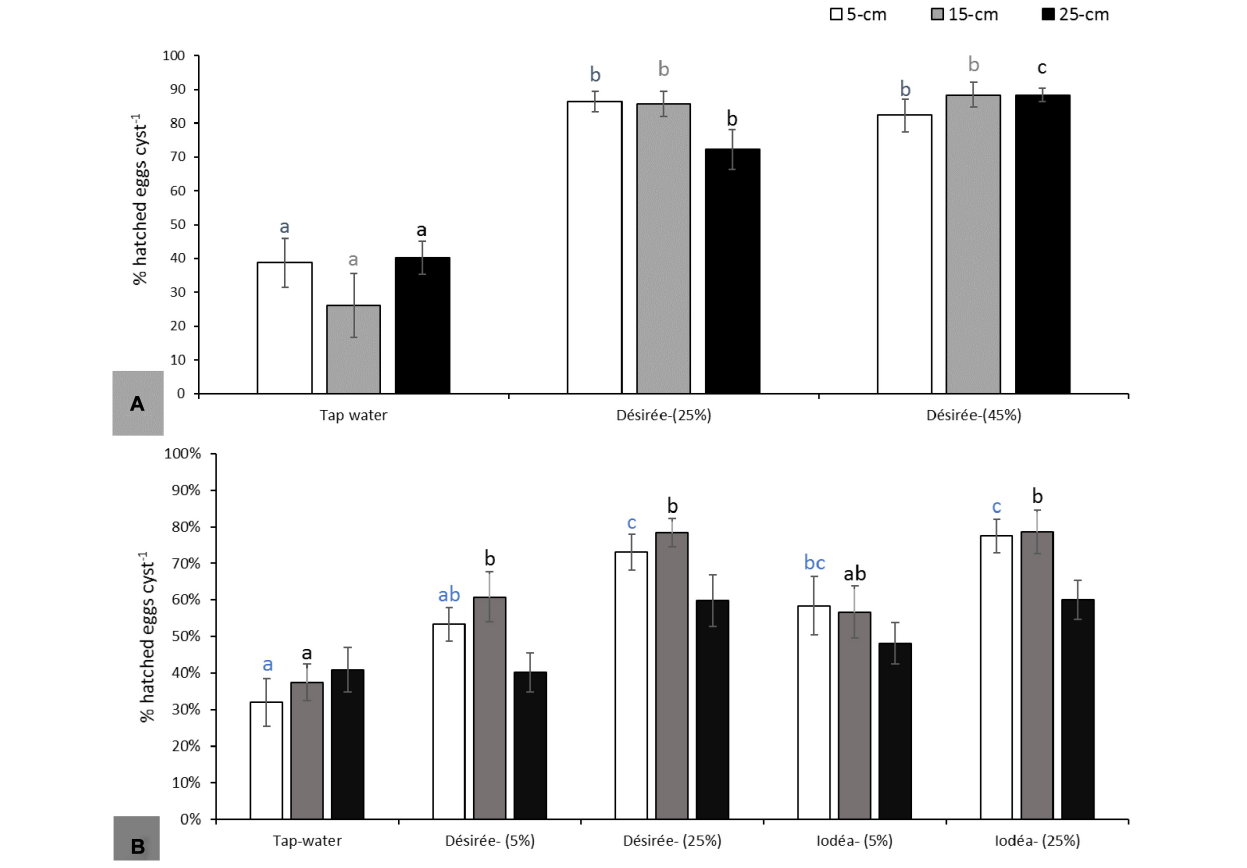
FIGURE 3 | Hatching of Globodera pallida at 5, 15, and 25 cm soil depth following application of Désirée or Iodéa root exudates from top soil at 5, 25, or 45% concentration of the crude root exudates as compared with tap water in 2018 (A) and the repeated experiments in 2019 (B) . Different colored lowercase letters above the error bars represent significant differences between treatments for the same soil depth according to Tukey test (5% significance